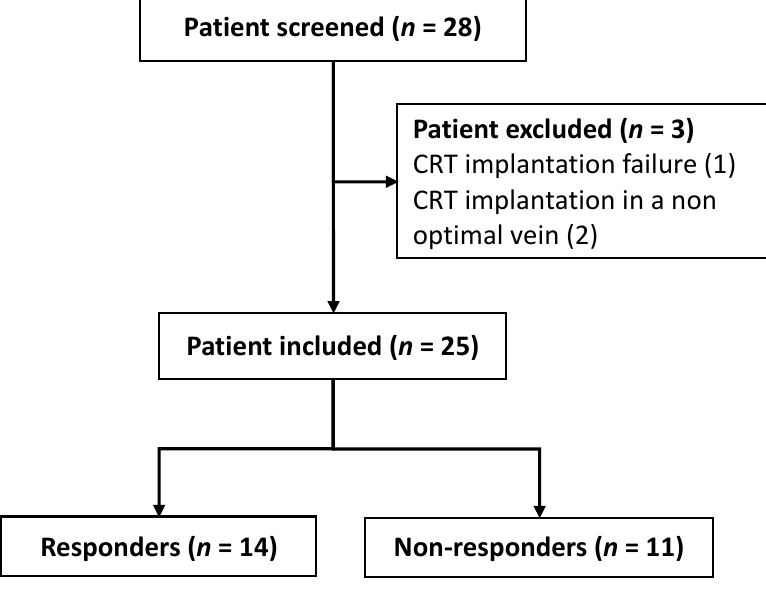
Figure 1. Study flow chart.